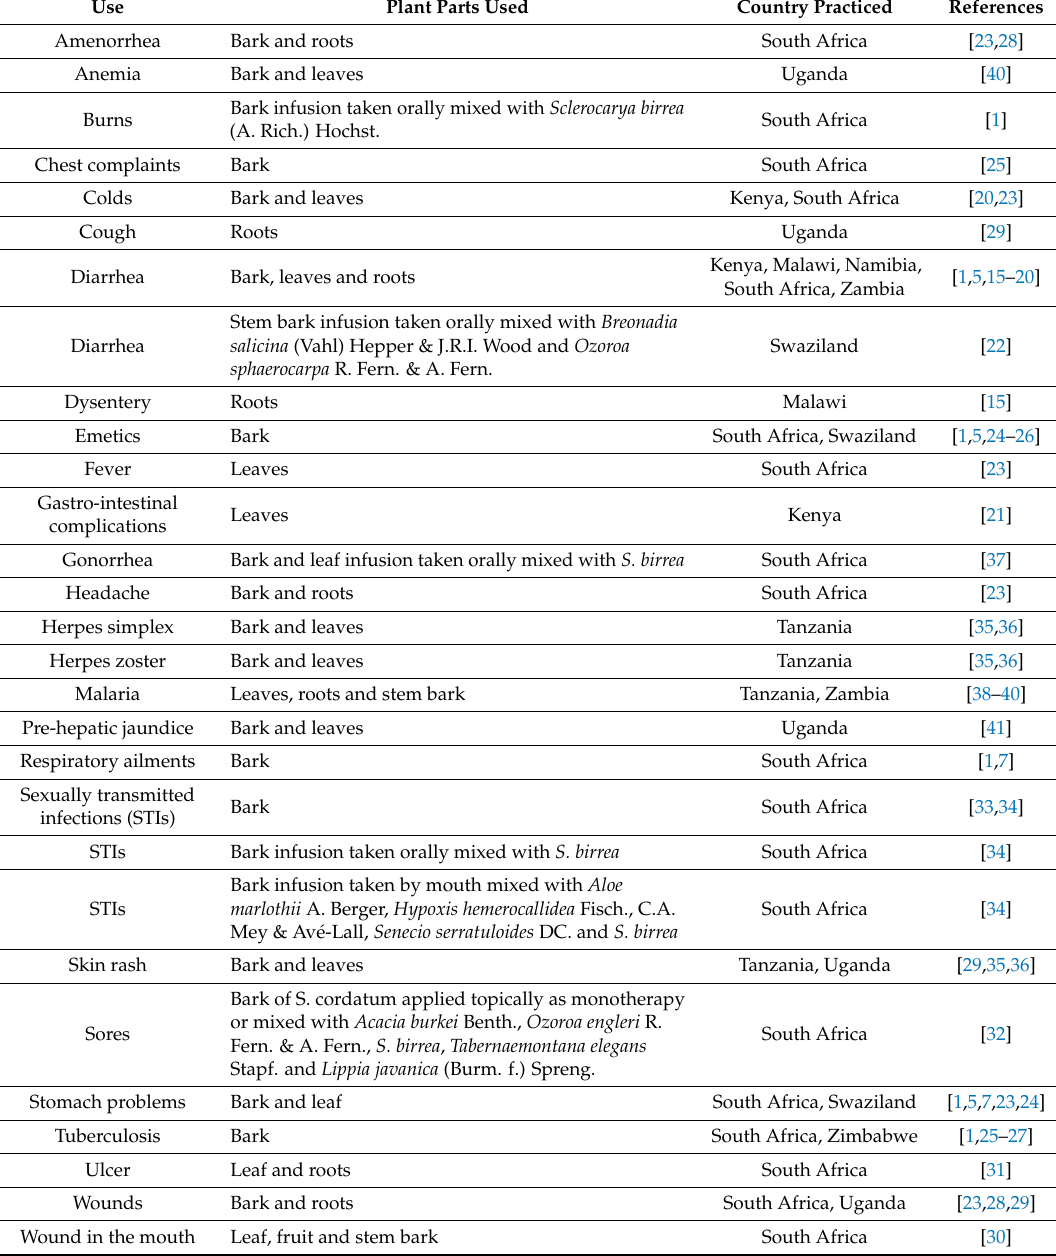
Table 1. Medicinal applications of Syzygium cordatum in east and southern Africa.